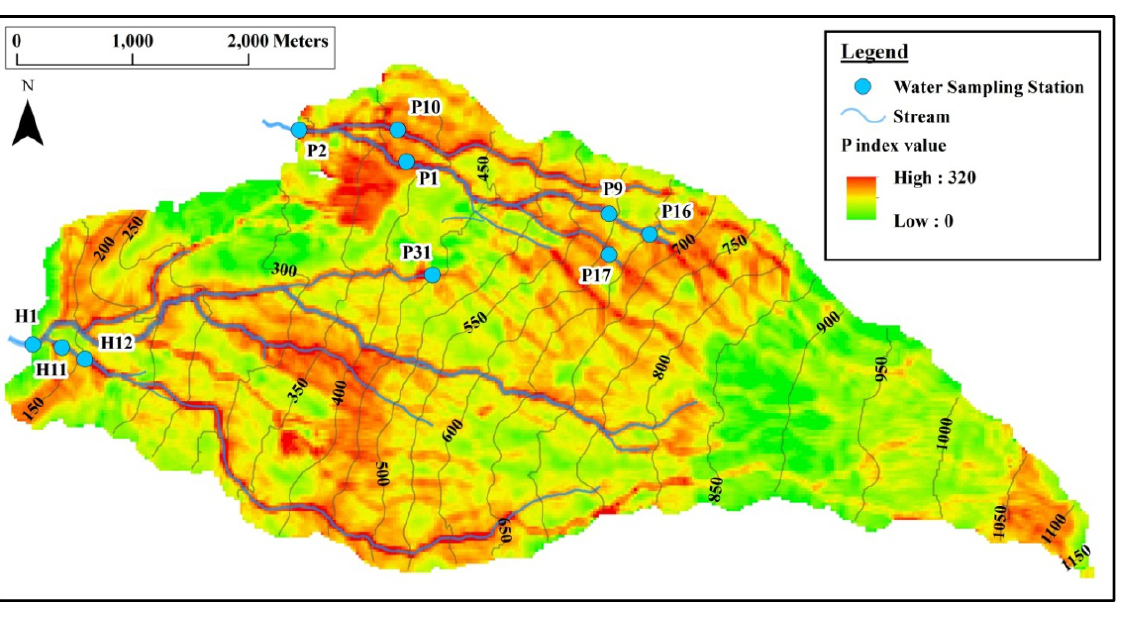
Figure 5. The Hermon model P-index map. The model emphasizes the importance of the areas located close to the stream beds, while the upper part of the basin is less likely to contribute P to the